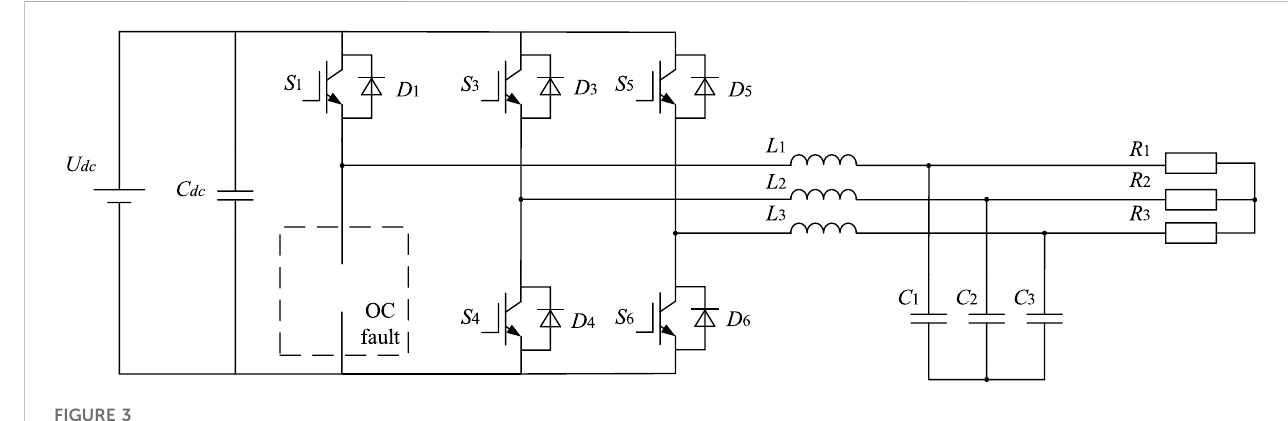
FIGURE 3 Topology of three-phase inverter with OC fault of S 2 .